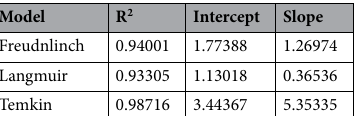
Table 1. Rate order kinetics for adsorption isotherm models.